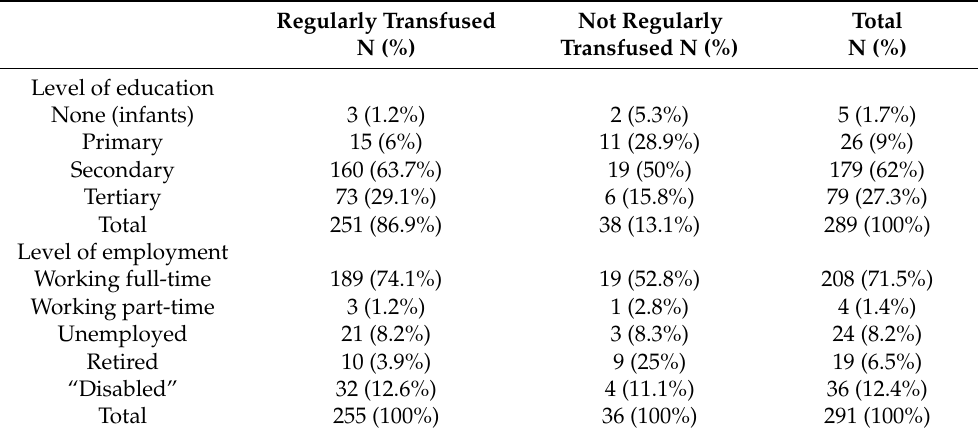
Table 4. Levels of education and employment in patients with thalassaemia in Cyprus according to transfusion status.